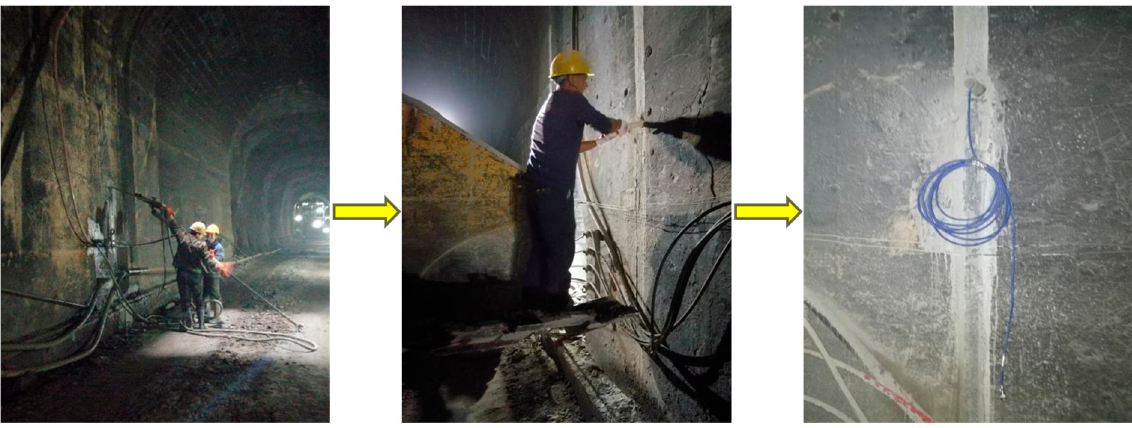
Figure 4. Stress gauge installation at the